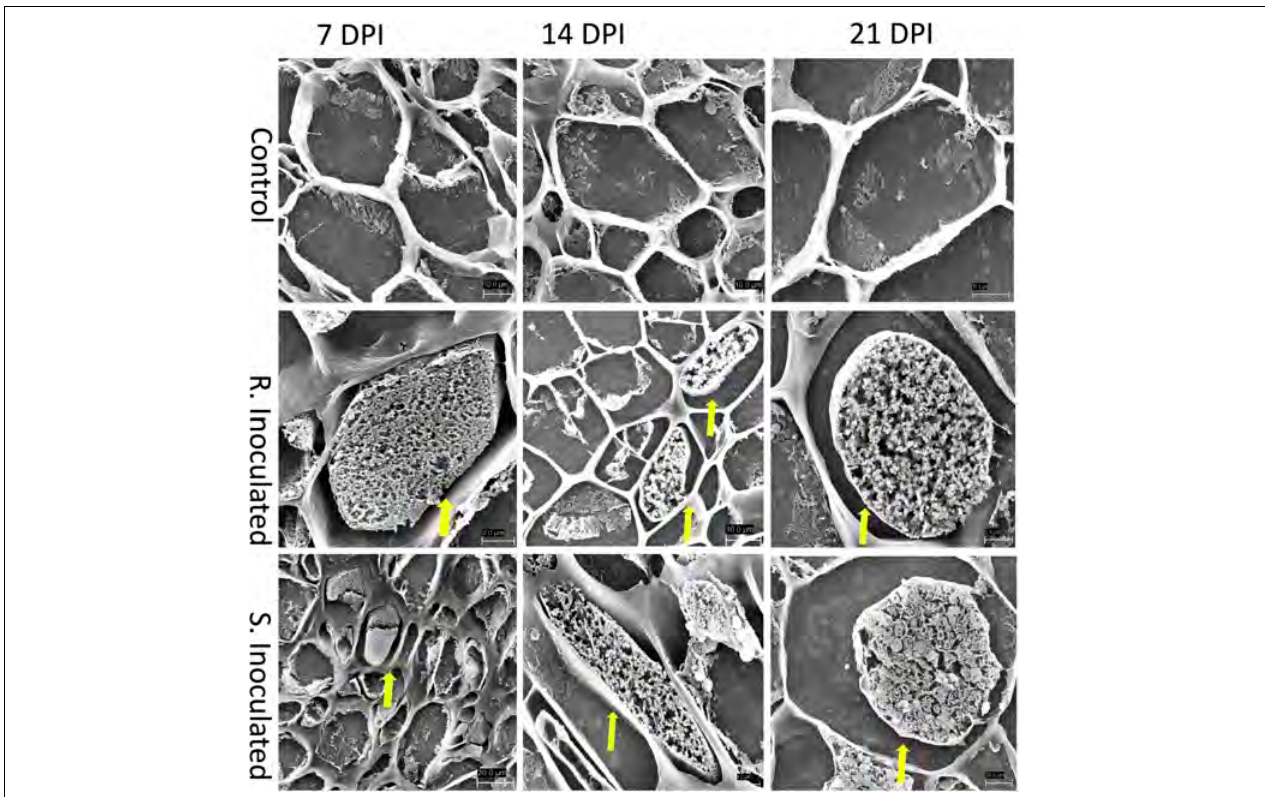
FIGURE 3 | Scanning electron micrograph (SEM) of root cross sections after P. brassicae infection at 7-, 14-, and 21-DPI. Each column indicates days after inoculation of the pathogen and the rows show the control and inoculated genotypes (CR and CS). At 7 DPI, infected cells showed primary plasmodia within cells indicated by the solid yellow arrow. At 14 DPI, CS inoculated line showed the presence of secondary plasmodia; however, the pathogen development on the CR inoculated line was not progressed to secondary plasmodia phase. At 21 DPI, pathogen clearly progressed to secondary plasmodia phase, maturing into resting spores. However, the infection development was not progressed in the CR line at the